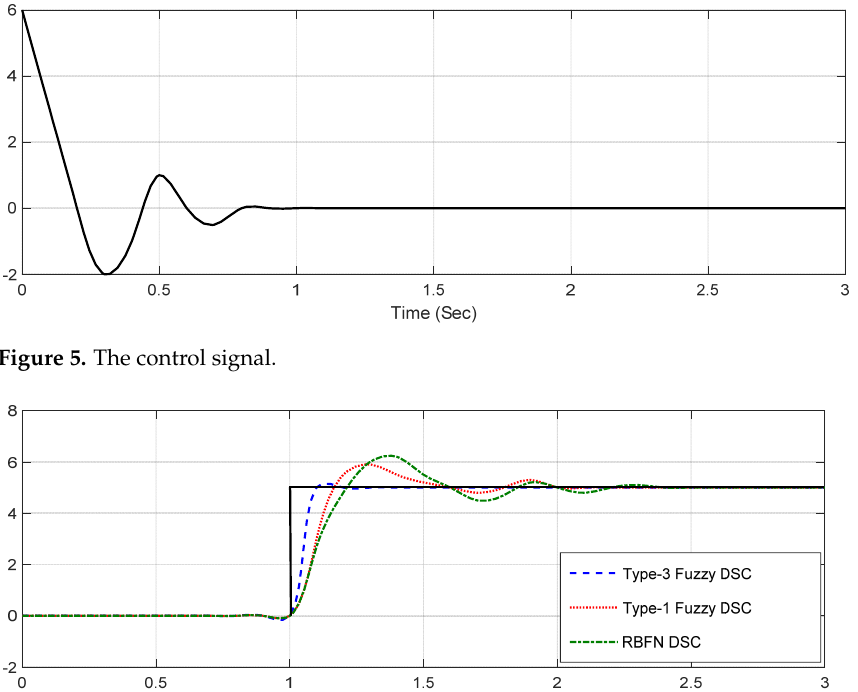
Figure 5. The control signal.